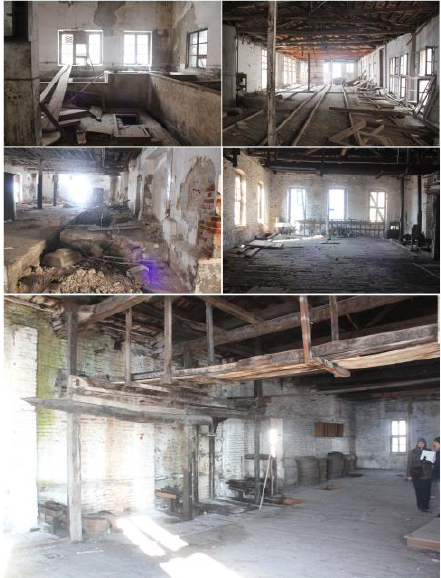
Figure 6 : Ertem Olive Oil Factory (taken by Gözde Yıldız,